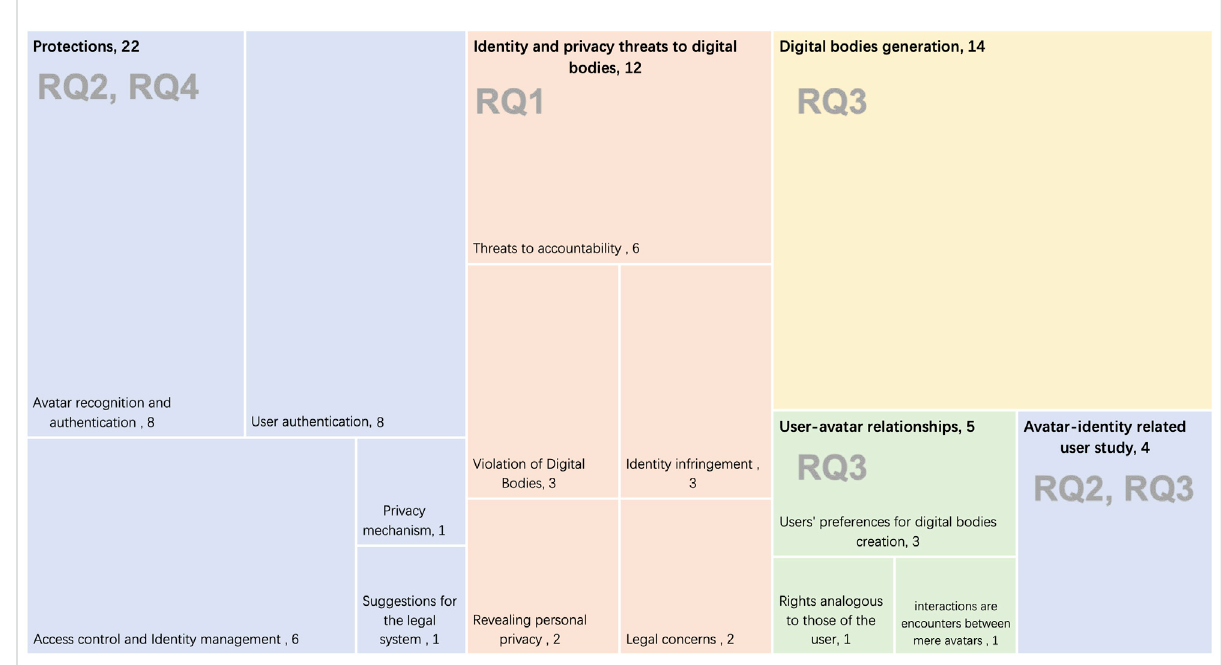
FIGURE 3 Distributionofselectedpapersacrosscategoriesandsubtopics,andtheirrelationshiptotheresearchquestions.Assomepapersappearseveral times, the numbers do not add up to the total number of papers, nor number in each category.